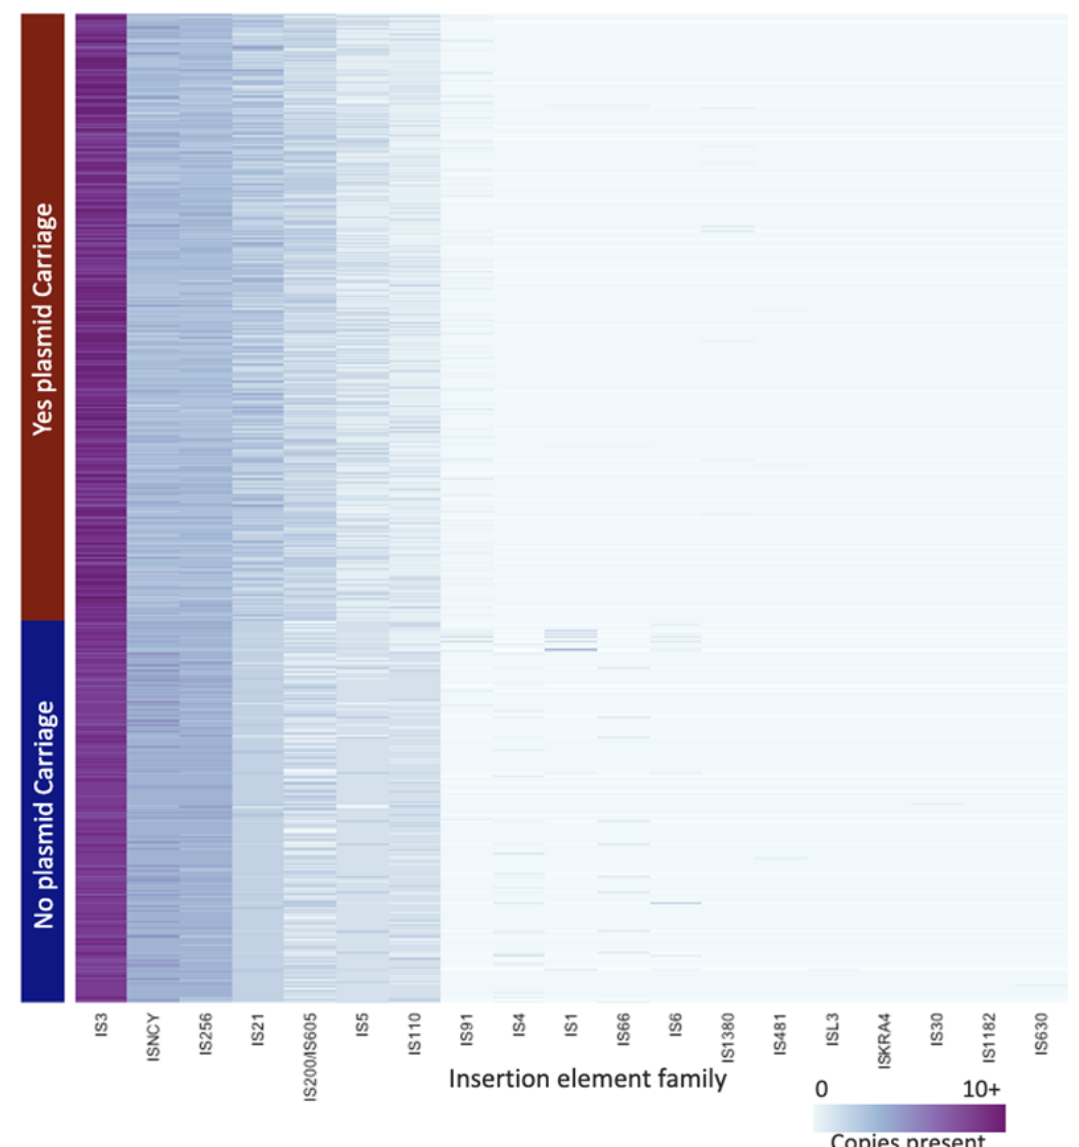
Figure 5. Heat map of number of insertion elements present in each chromosome. Each row represents a different isolate and is grouped by if the chromosome carries the pESI plasmid; each column is a different insertion element family. The darker the cell the higher number of insertion elements from that family are present in that strain.